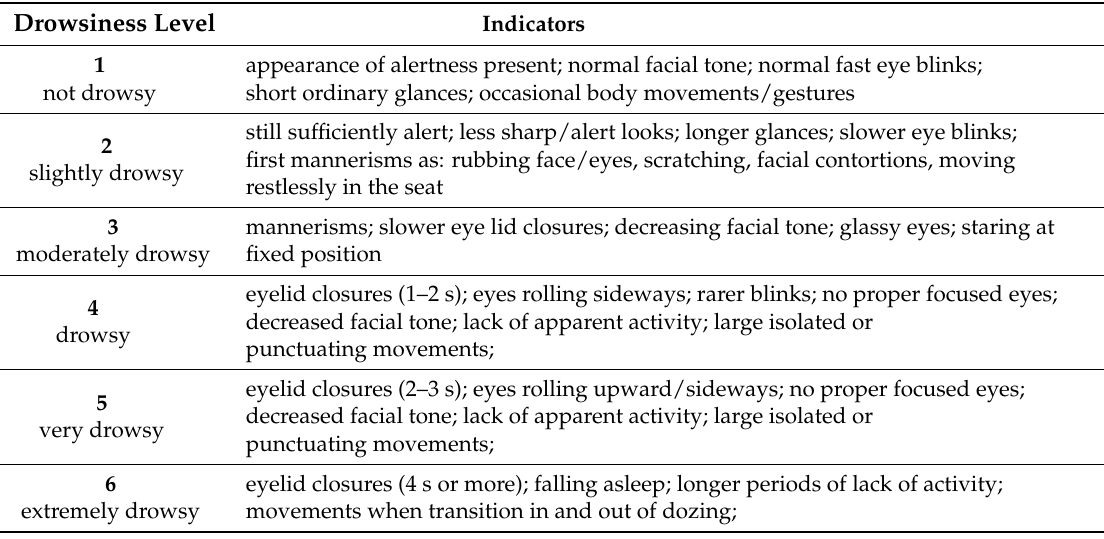
Table 1. Scale for video ratings with indicators per level